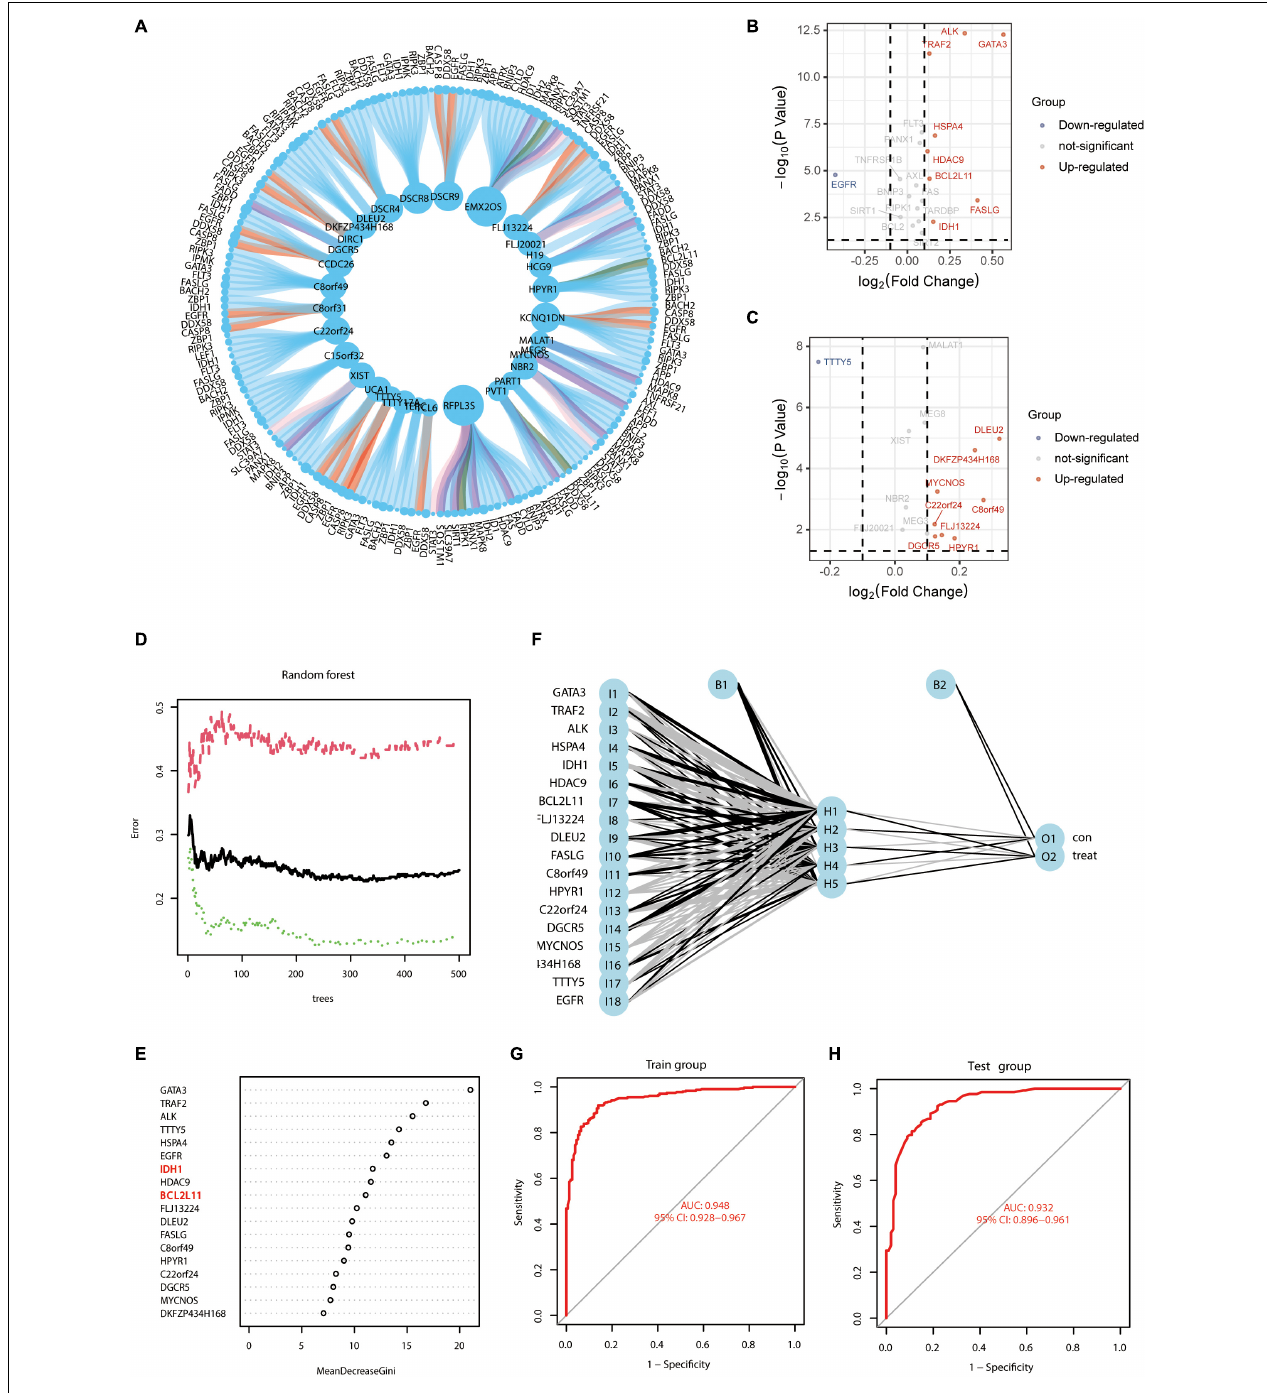
FIGURE 2 | Screening of necroptosis-associated mRNAs and lncRNAs in AD brain tissue to construct AD risk score scores. (A) Circle diagram of necroptosis-related lncRNAs–mRNAs correlation analysis; lncRNAs are in the middle of the circle, and mRNAs are in the outer periphery of the circle. Linkage of peripheral circle origin to inner circle origin indicates a significant correlation. Red connecting lines indicate that these mRNAs are highly expressed in AD, and purple indicates that these mRNAs are lowly expressed in AD. (B) Volcano map of necroptosis-related mRNAs differentially expressed in AD. (C) Volcano map of necroptosis-related lncRNAs differentially expressed in AD. (D) Prediction error diagram of random forest model; green line indicates training group error, red line indicates test group error and black line indicates overall group error. (E) Importance analysis of genes in predicting AD in random forest, filtering all genes with scores greater than 2 according to the model with the lowest error point in panel (D) . (F) Schematic diagram of a neural network model for AD diagnosis prediction based on gene expression features. (G,H) ROC curves of the AD neural network prediction model for the training group (AUC = 0.948; 95% CI: 0.928–0.967) and the test group (AUC = 0.932; 95% CI: